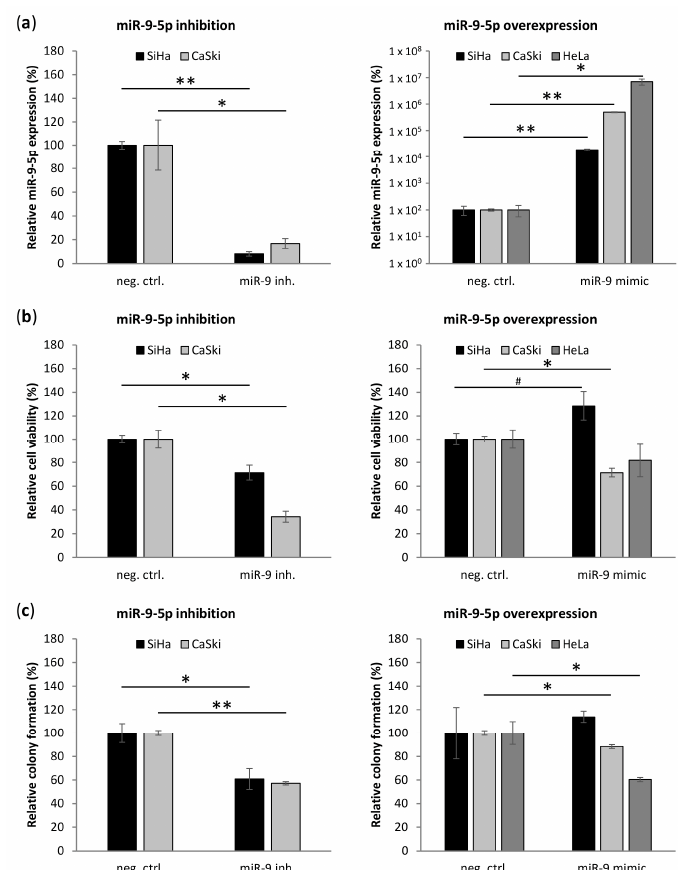
Figure 3. Effect of miR-9-5p on cervical cancer cell lines. ( a ) miR-9-5p levels; ( b ) cell viability, and ( c ) colony formation in soft-agar upon inhibition (left panel) and overexpression (right panel) of miR-9-5p in cervical cancer cell lines SiHa, CaSki, and HeLa relative to the respective negative control. The miR-9-5p inhibition experiment was not performed in HeLa due to very low endogenous levels of miR-9-5p in this cell line. # p < 0.1, * p < 0.05, ** p <